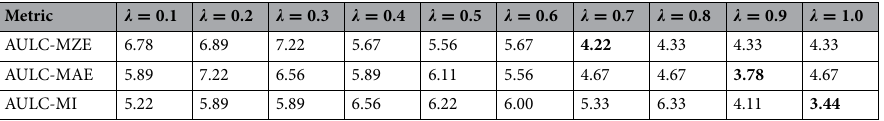
Table 4. Average rank of the AOCECM methods with different (cid:31) values on the metrics AULC-MZE, AULC- MAE, and AULC-MI.